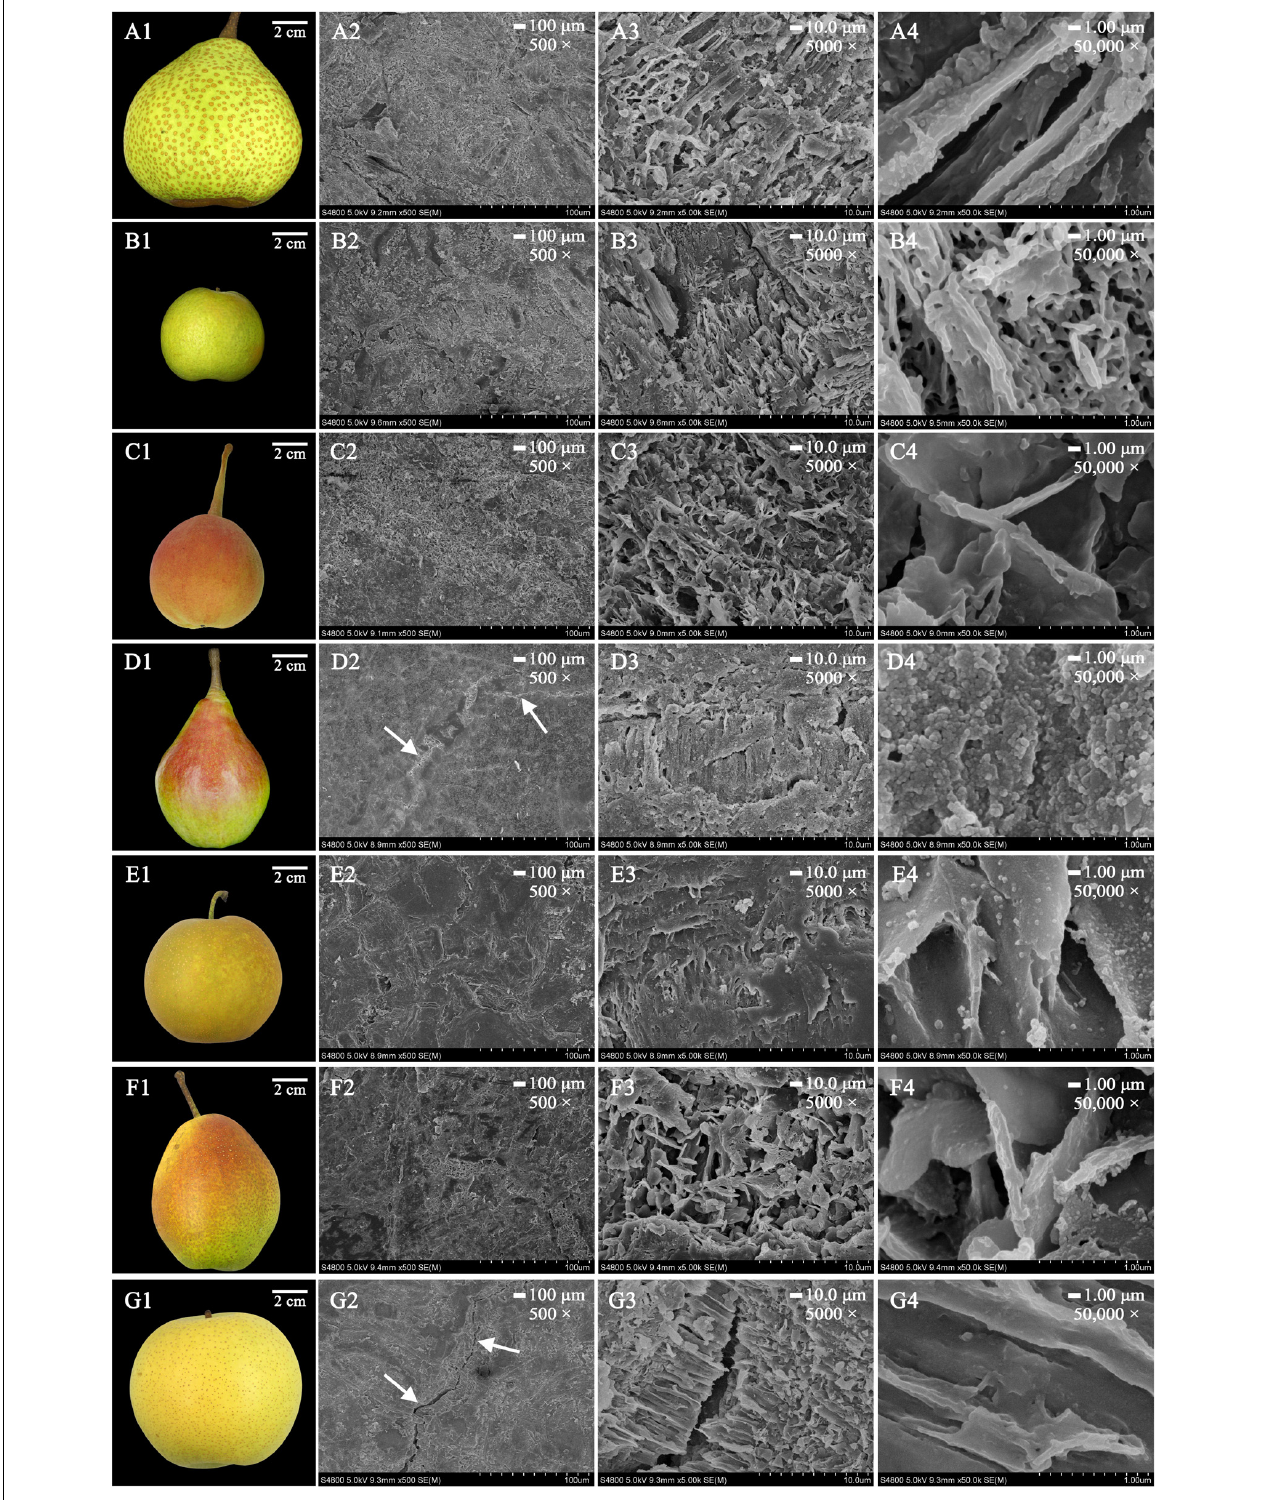
FIGURE 3 | The morphology of mature fruits and the magnification series of the FESEM images of epicuticular wax in seven pear cultivars. (A1–G1) Are mature fruits of ‘Chili’, ‘Nanguoli’, ‘Kucheamute’, ‘Clapp Favorite’, ‘Shinseiki’, ‘Hongxiangsu’ and ‘Zhongli No. 2’, respectively. Scale bars represent 100 µ m (magnification 500 × ) in (A2–G2) , 10.0 µ m (magnification 5000 × ) in (A3–G3) and 1.00 µ m (magnification 50,000 × ) in (A4–G4) . The white arrow denotes the most prominent wax crack.